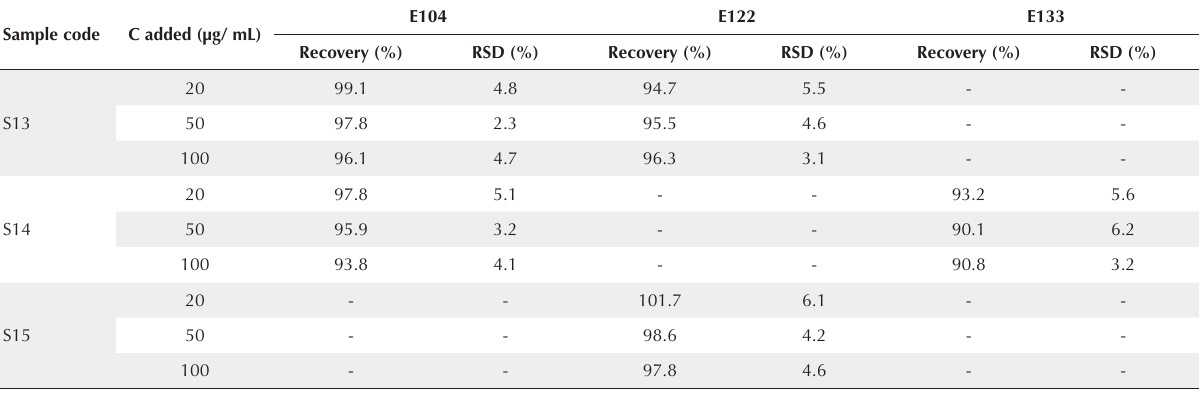
Table 7. Recovery and RSD of 3 Food Dyes [Carmoisine (E122), Quinolone yellow (E104) and Brilliant blue (E133)] spiked at 3 levels (20, 50&100 µg/mL) to Fruit Roll-ups (lavashak) Sample